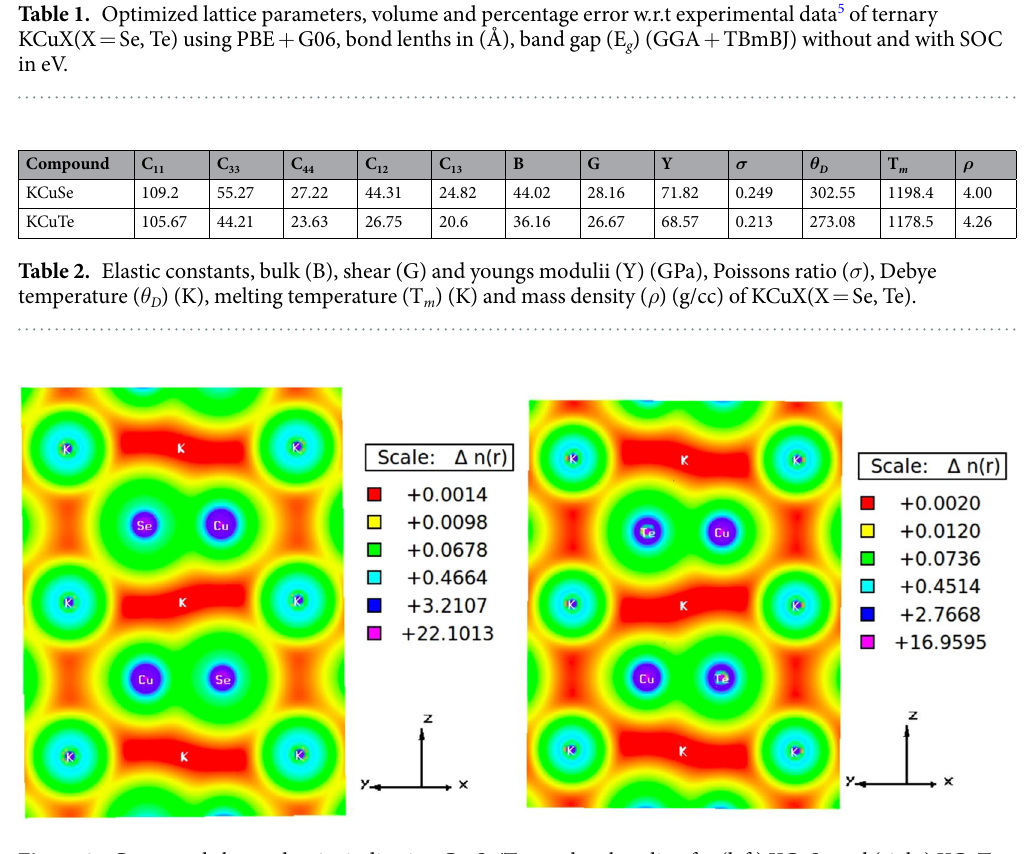
Figure 2. Computed charge density indicating Cu-Se/Te covalent bonding for (left) KCuSe and (right) KCuTe at ambient conditions.